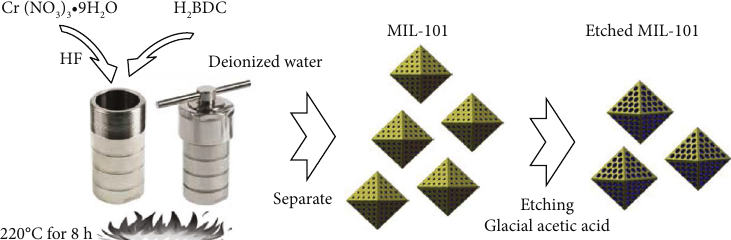
Figure 1: Schematic diagram of preparation process of the etched